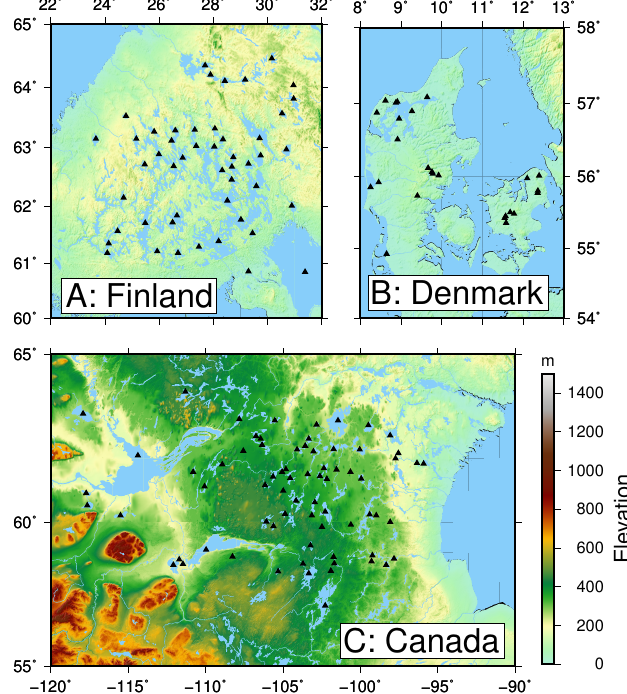
Figure 3. An overview of the lakes included in the